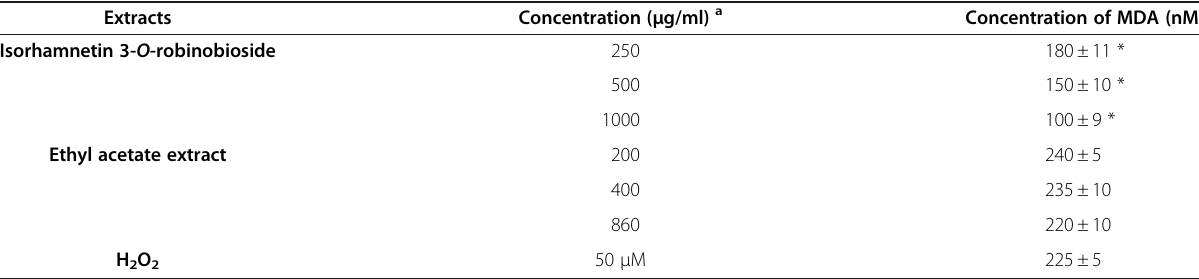
a results are represented by the means±SD of three experiments. (*) p <0.05 means a significant difference between the treated cells with isorhamnetin 3- o -robinobioside (I3- O -Rob) and ethyl acetate (EA) extract, and cells treated with hydrogen peroxide (H 2 O 2